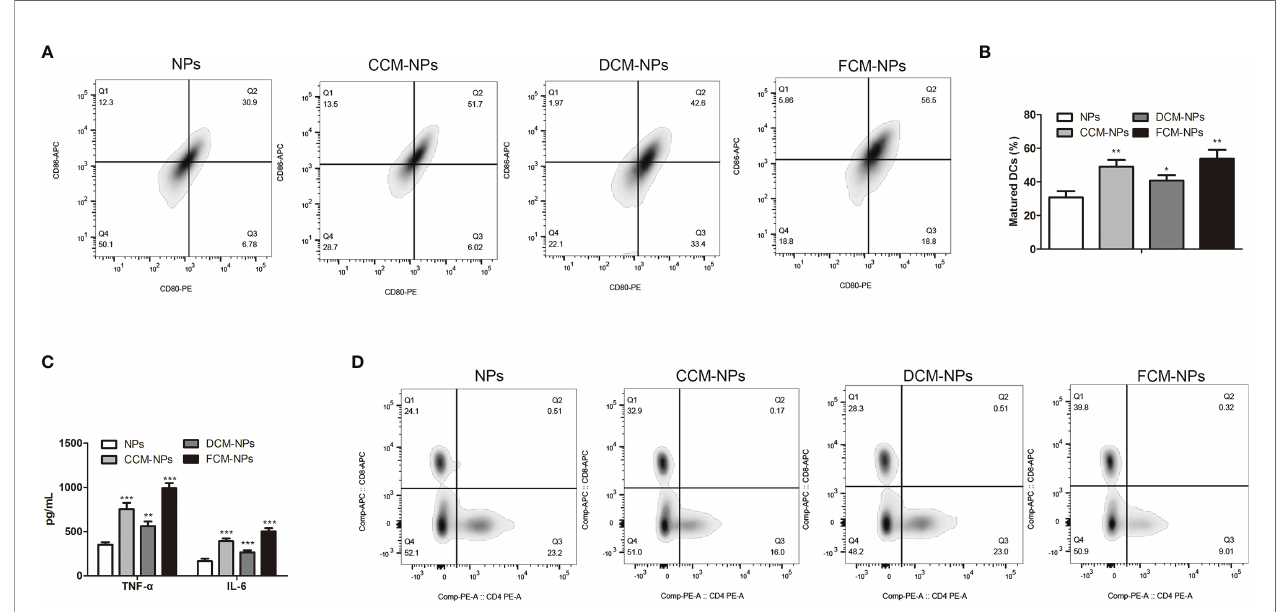
FIGURE 3 | In vitro immune activation of FCM-NPs. (A) Flow cytometry analyses of the mature biomarkers CD86-APC and CD80-PE of BMDCs co-incubated with NPs, CCM-NPs, DCM-NPs and FCM-NPs. (B) Maturation rate of BMDCs in each group. (C) Levels of TNF- a and IL-6 secreted by BMDCs determined by ELISA. (D) Flow cytometry analyses of the expression of CD8 and CD4 in splenic lymphocytes co-incubated with BMDCs activated by NPs, CCM-NPs, DCM-NPs and FCM-NPs. * P < 0.05, ** P < 0.01, *** P < 0.001 vs NPs